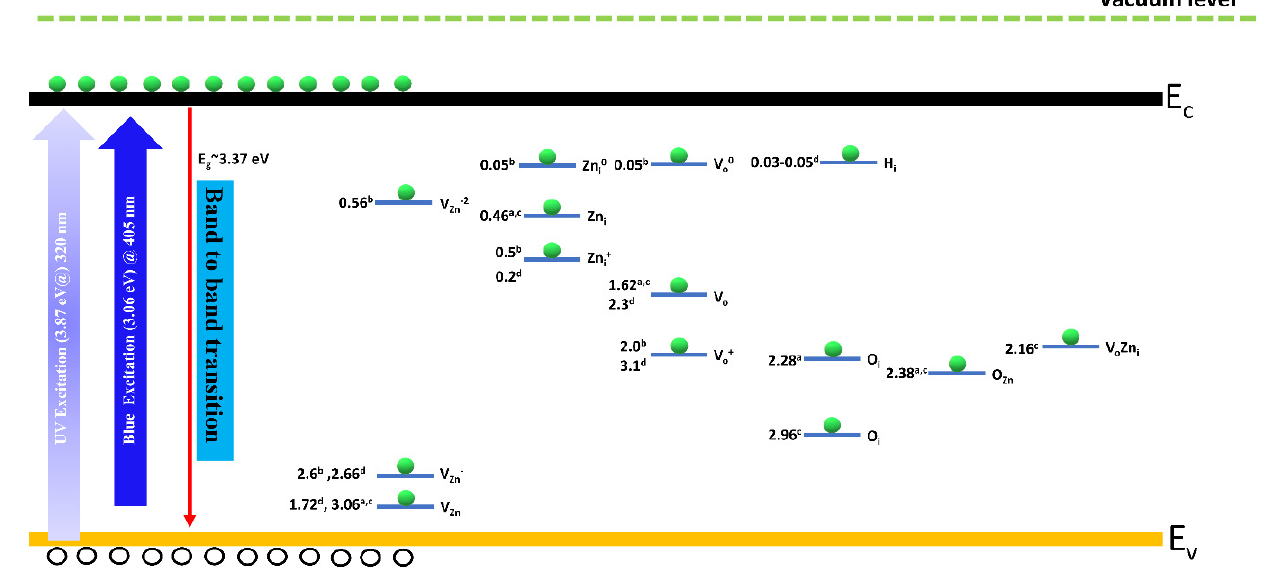
Figure 6. Schematic illustration of energy levels of different possible intrinsic defects in ZnO. The values has been extracted from previous reports: (a) ref. [38] (b) ref. [39] (c) ref. [40] and (d) ref. [41]. The light blue and bluish violet arrow represent the excitation wavelength used in the current study, V Zn , V Zn − , and V Zn − 2 indicate the neutral, singly charged, and doubly charged Zn vacancies, respectively. Neutral and singly charged Zn interstitials are denoted by Zn i , and Zn i+ . Neutral and singly charged oxygen vacancies are denoted by V o , V o0 , and V o+ . O i and H i indicate the oxygen and hydrogen interstitials, respectively. The V o Zn i here represents the defect complex containing the oxygen vacancy and Zn interstitial.